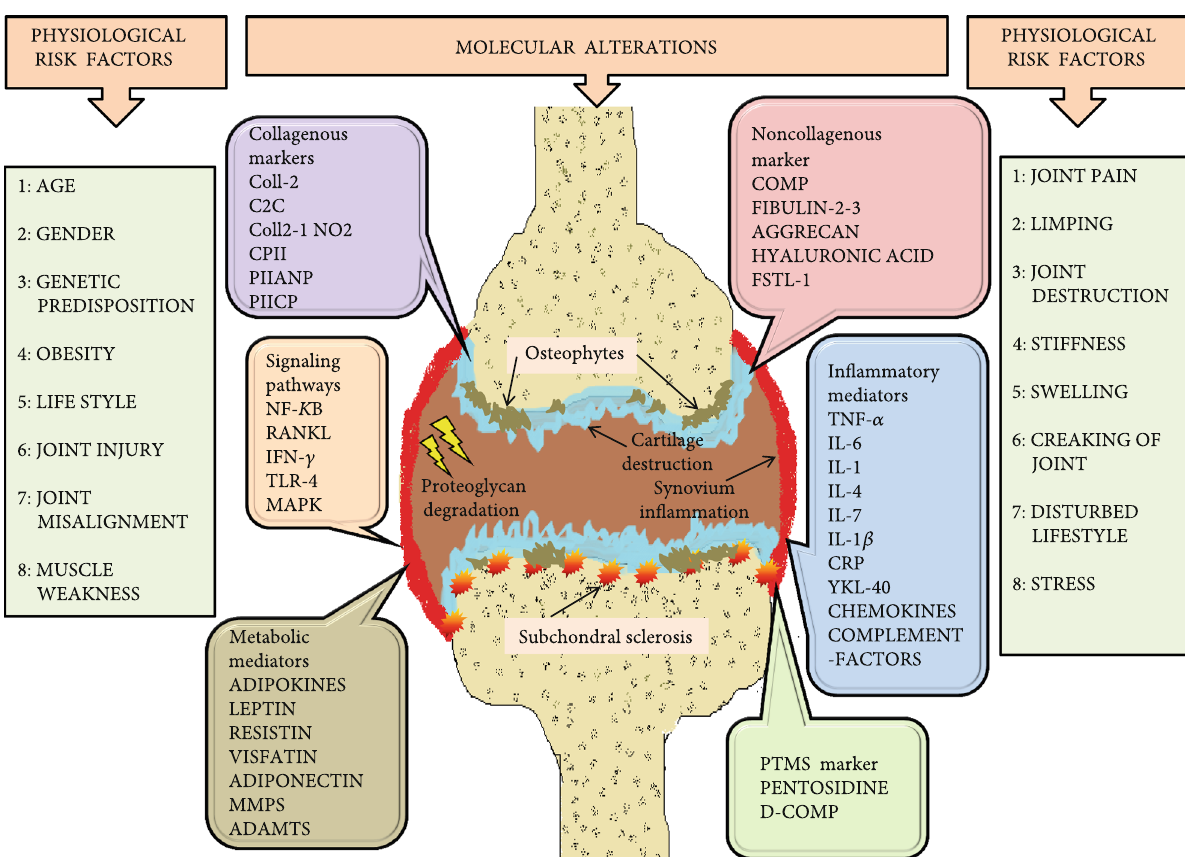
Figure 2: Physiological, molecular, and metabolic alterations are responsible for the cause of osteoarthritis. CPII: type II collagen propeptide; C2C: neoepitope of type II collagen; Coll 2-1: 9-amino acid peptide of type II collagen (nitrated form Coll 2-1 NO telopeptide of collagen; PIIANP: N-propeptide IIA of type II collagen; PIICP: C-propeptide of collagen type II; COMP: cartilage oligomeric matrix protein; FSTL-1: follistatin-like protein 1; CRP: C-reactive protein; IL: interleukin; TNF: tumor necrosis factor;